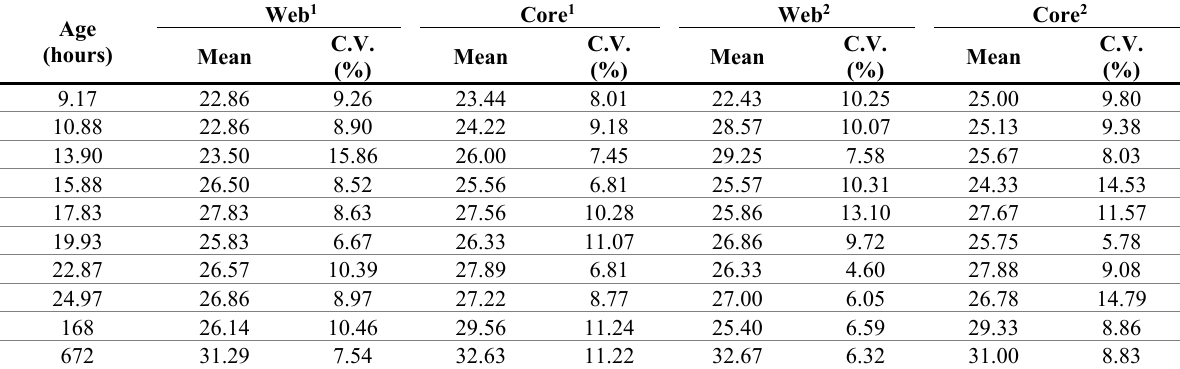
Rebound measurements were divided into two groups according to their position (Table 5), i.e., above the webs (1, 2, 3, 9, 10 and 16) and over the cores (4, 5, 6, 7, 8, 12, 13, 14 and 15). Readings different from the average by more than 6 units were discarded, as recommended by ASTM C805/C805M [44]. This procedure was applied to each group separately. F-test was applied to the rebound numbers followed by T-test (Table 6). The former showed the variances in the two groups were equal, whereas T-test indicated the measurements above the webs or cores were not significantly different in most cases. The results were obtained in both regions of the hollow-core slab with and without reinforcements, however, in the former, three ages exhibited probabilities for T-test lower than 5%. Table 5 – Rebound measurements of the second phase of the experimental program divided by groups.